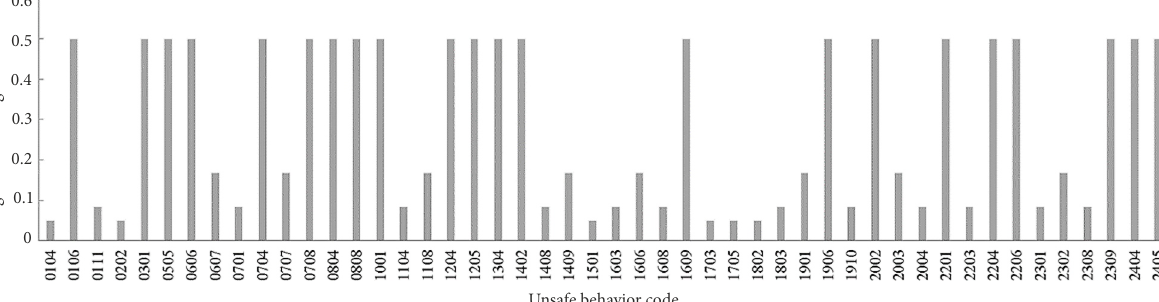
Figure 8. Weighted clustering coefficients